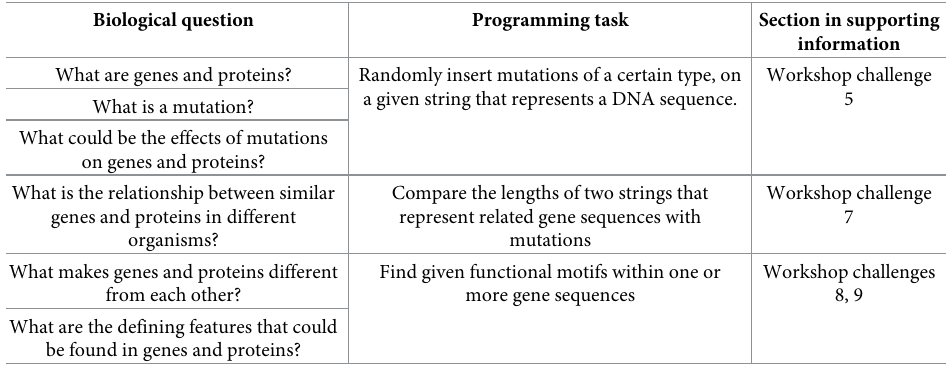
Table 3. Some biological questions made during workshops and the proposed programming task to address